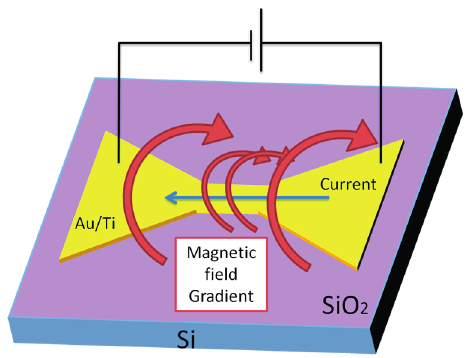
Figure 21. The basic concept of “magnetic washing” via magnetic field gradient, induced by an applied current thorough a gold layer. Adapted from